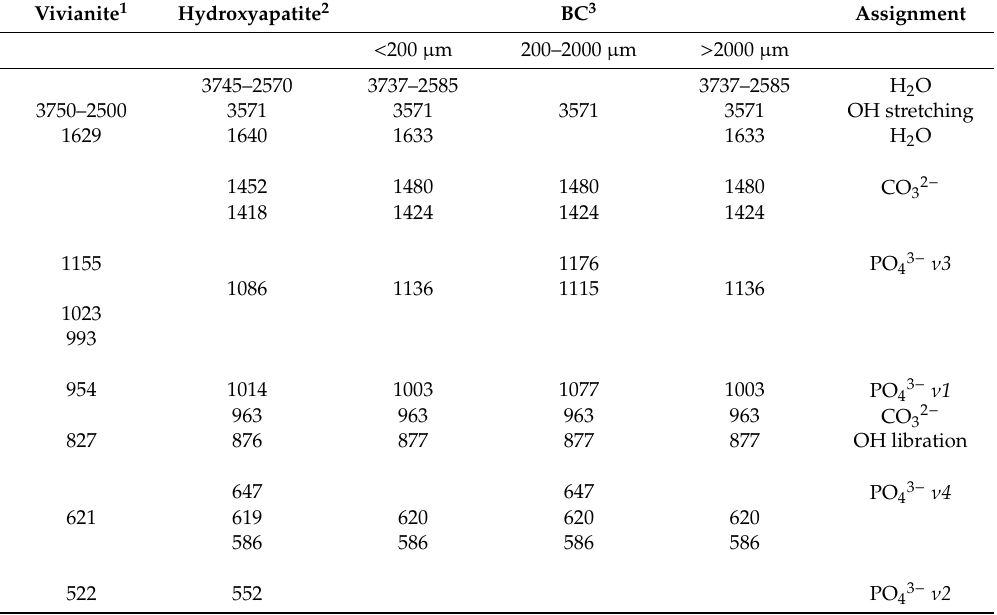
Table 7. Observed wavenumbers [cm − 1 ] of vivianite, hydroxyapatite, and bone char. Vivianite 1 Hydroxyapatite 2 BC 3